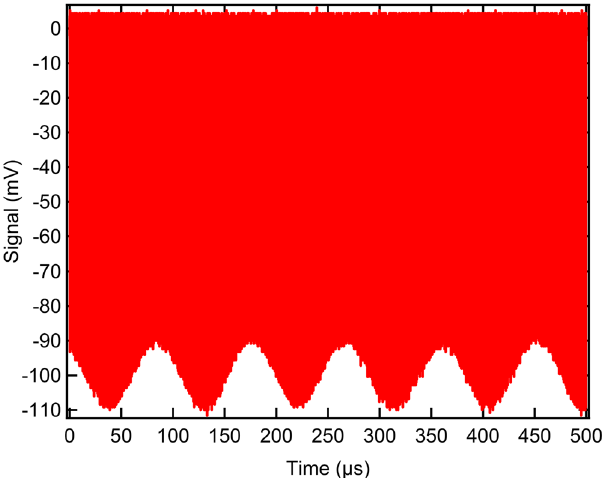
FIG. 2. Time-domain CSR spectrum showing oscillations due to the quadrupole ( m ¼ 2 ) eigenmode near threshold. The oscillation frequency is approximately 10.9 kHz and the syn- chrotron frequency is 5.4 kHz. The figure represents 877 turns of the storage ring.